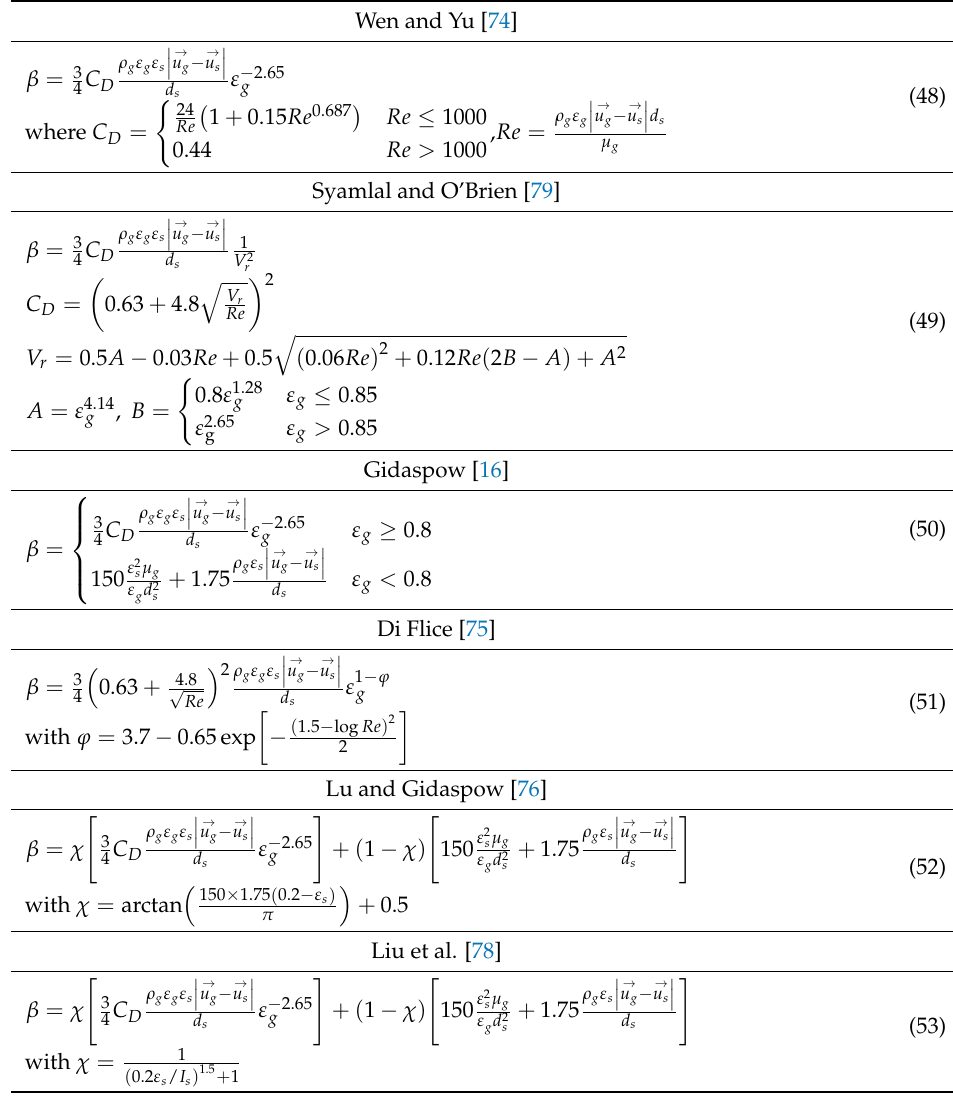
Table 12. Experiment-based drag models.